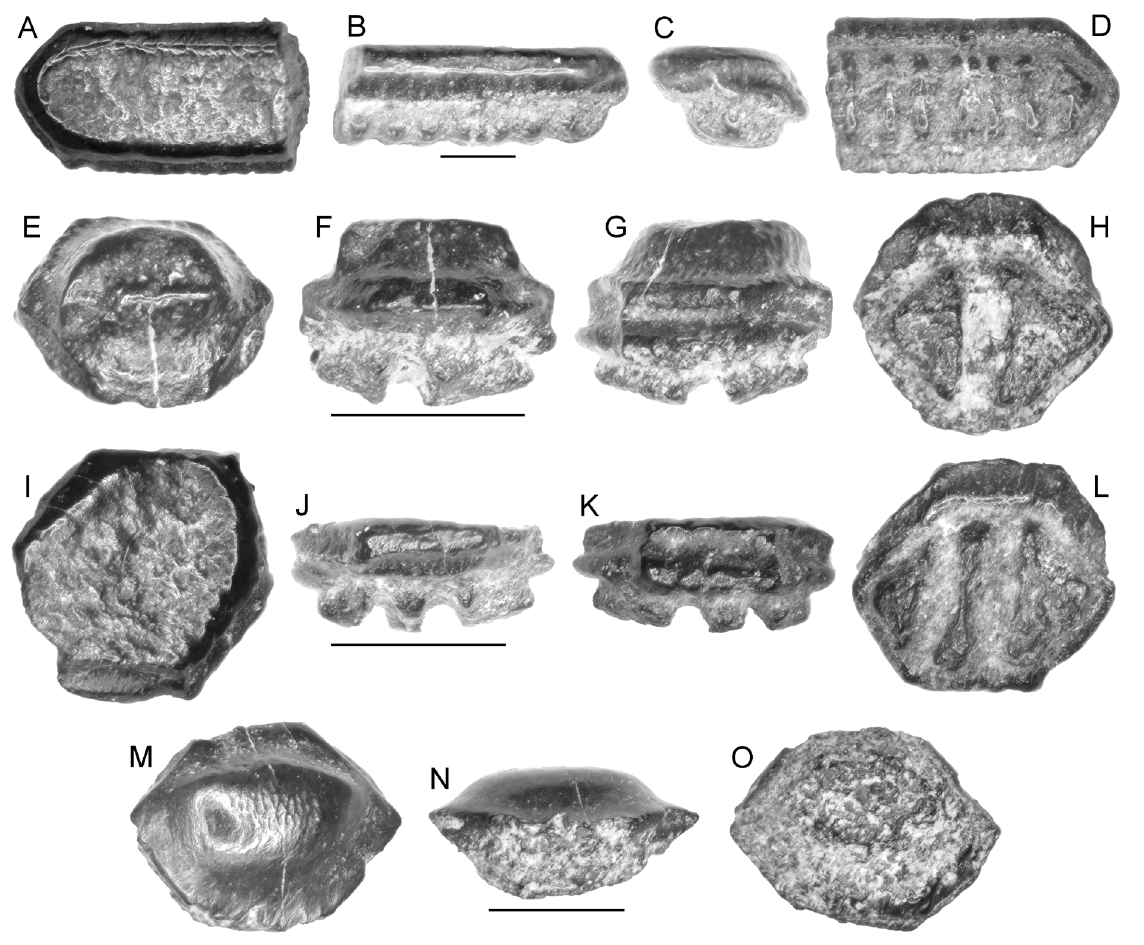
Fig. 51. Meridiania cf. M. convexa Case 1994, teeth. A–D . MSC 38877, median tooth, lower Tallahatta Formation. A . Oral view. B . Labial view. C . Profile view. D . Basal view. E–H . MSC 38822.2,